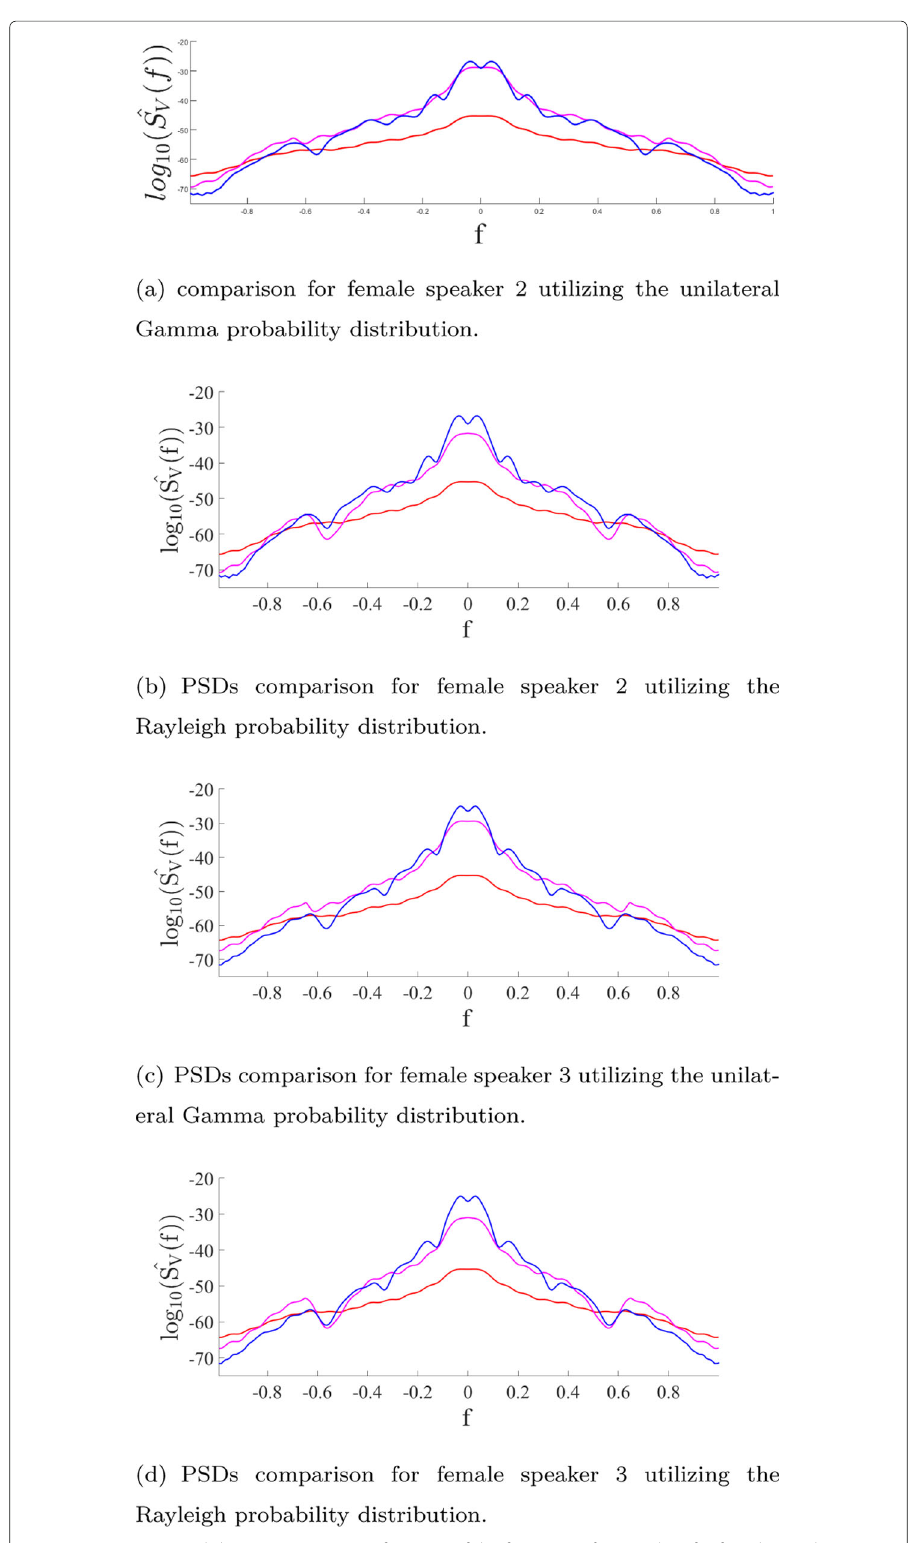
Fig. 15 Power spectral densities curves, as a function of the frequency f ( × π rad / s ) , for female speakers: new voice generation model (lilac), classic source-filter (red) and estimated by voice locution